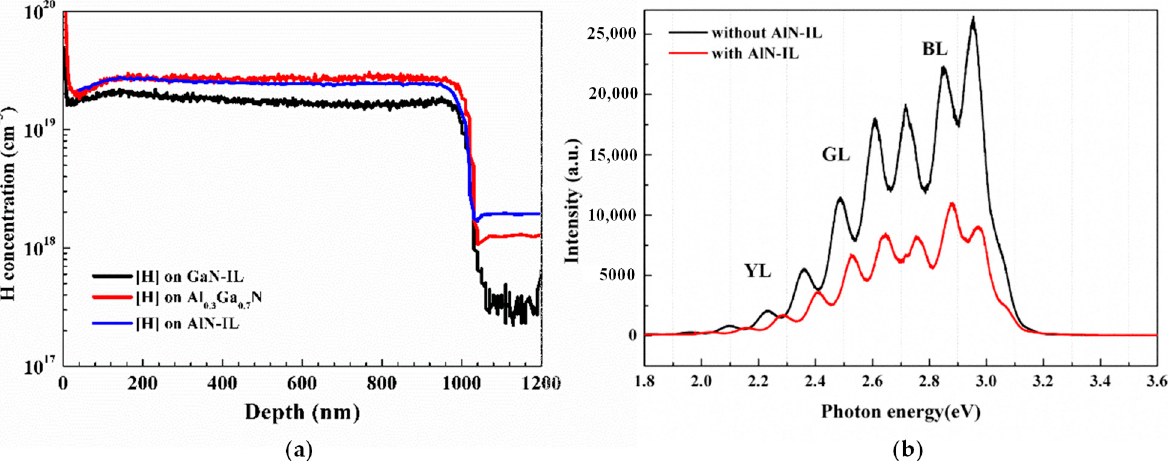
Figure 5. ( a ) The dependence of hydrogen concentration on depth investigated by SIMS. Black, red, and blue lines are results for p-GaN on GaN-IL, Al 0.3 Ga 0.7 N, and AlN-IL structures, respectively. ( b ) The low-temperature (10 K) PL spectra of p-GaN with and without AlN-IL.